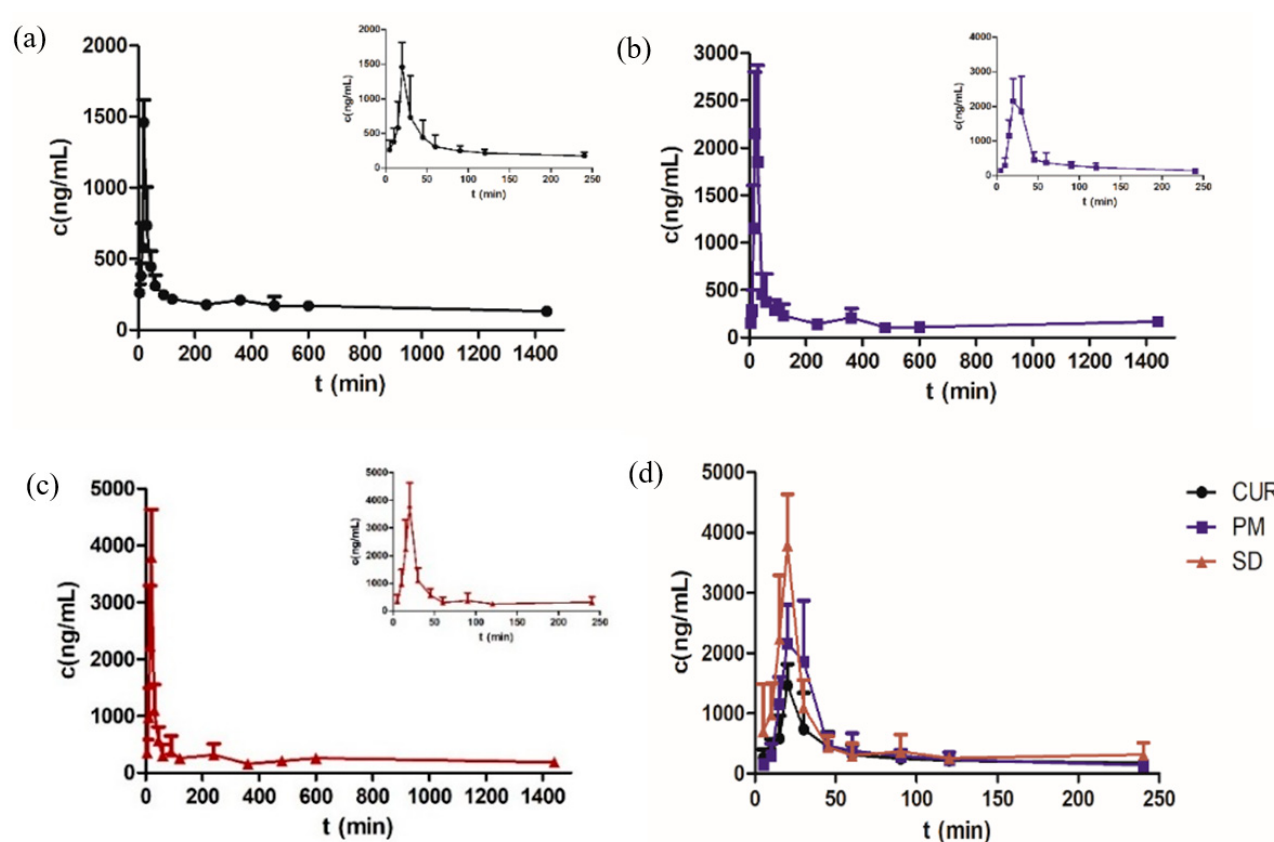
Figure 11. The DSC curves of the SD in different months.